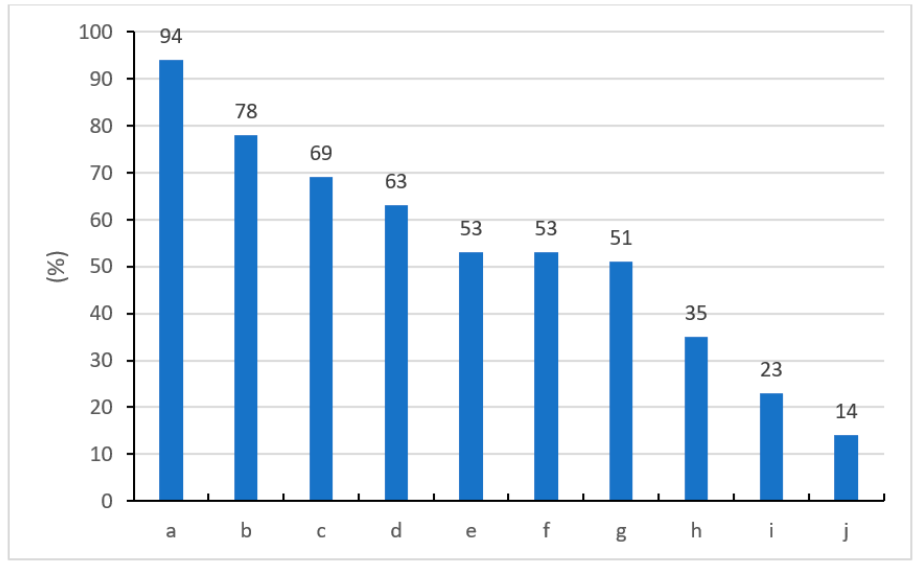
Figure 2. Knowledge about the European Union (EU).